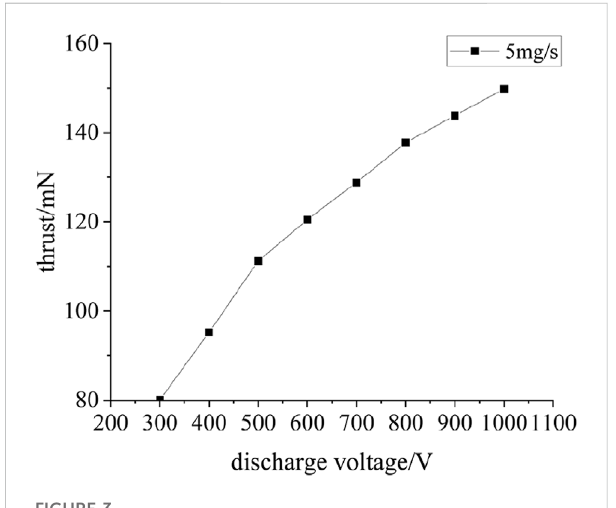
FIGURE 3 Simulated thrust with unchanged magnetic fi eld.